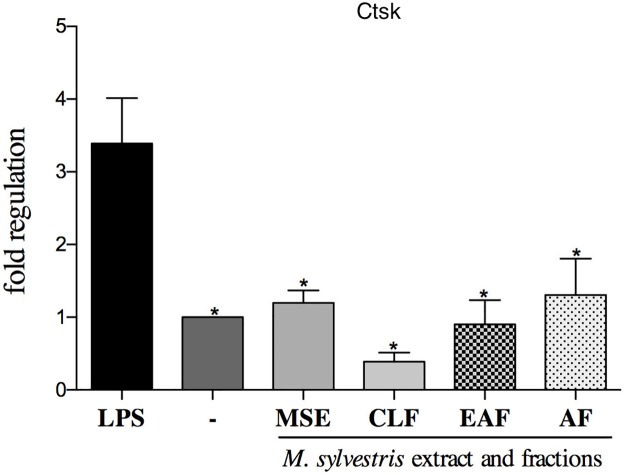
Effect of MSE and fractions on Ctsk (cathepsin K) expression levels.Quantification of the relative transcript amounts performed by qpcR with 10 ng of each cDNA. Data quantification was performed using 2(-DeltaDeltaC(T)). Statistical analyses were performed by one-way ANOVA followed by Dunnett’s post-hoc tests. *p<0.05 significantly different from LPS-stimulated cells.